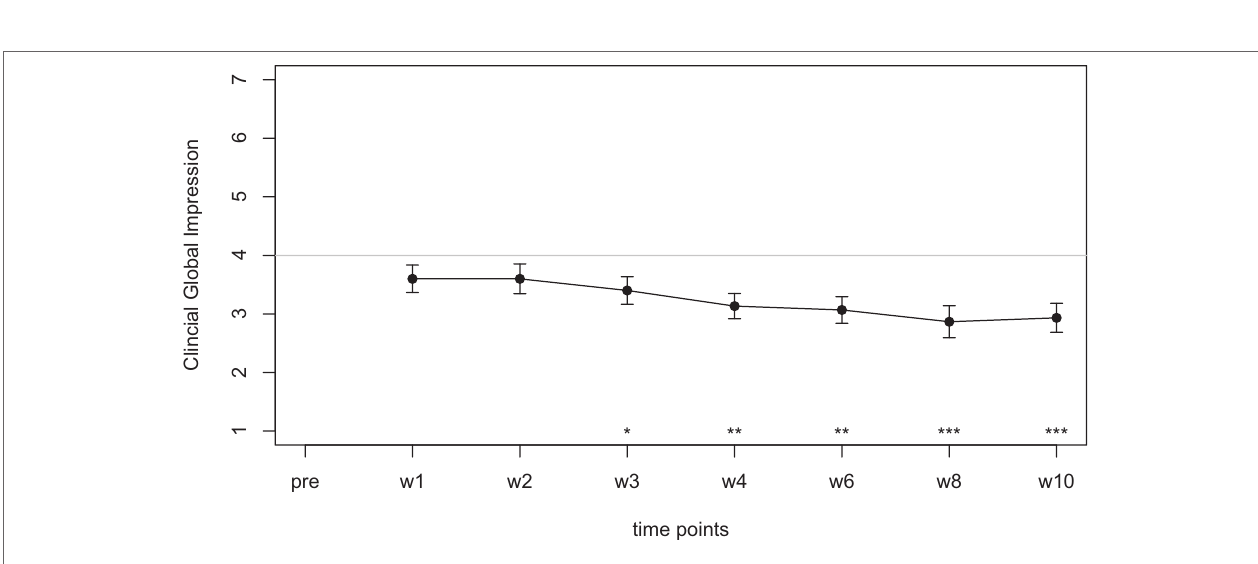
FigUre 1 | Average scores of the Tinnitus Handicap Inventory (THI) (0–100) before the treatment and at all visits during the study (weeks 1–8). The final assessment was done at the end of treatment in week